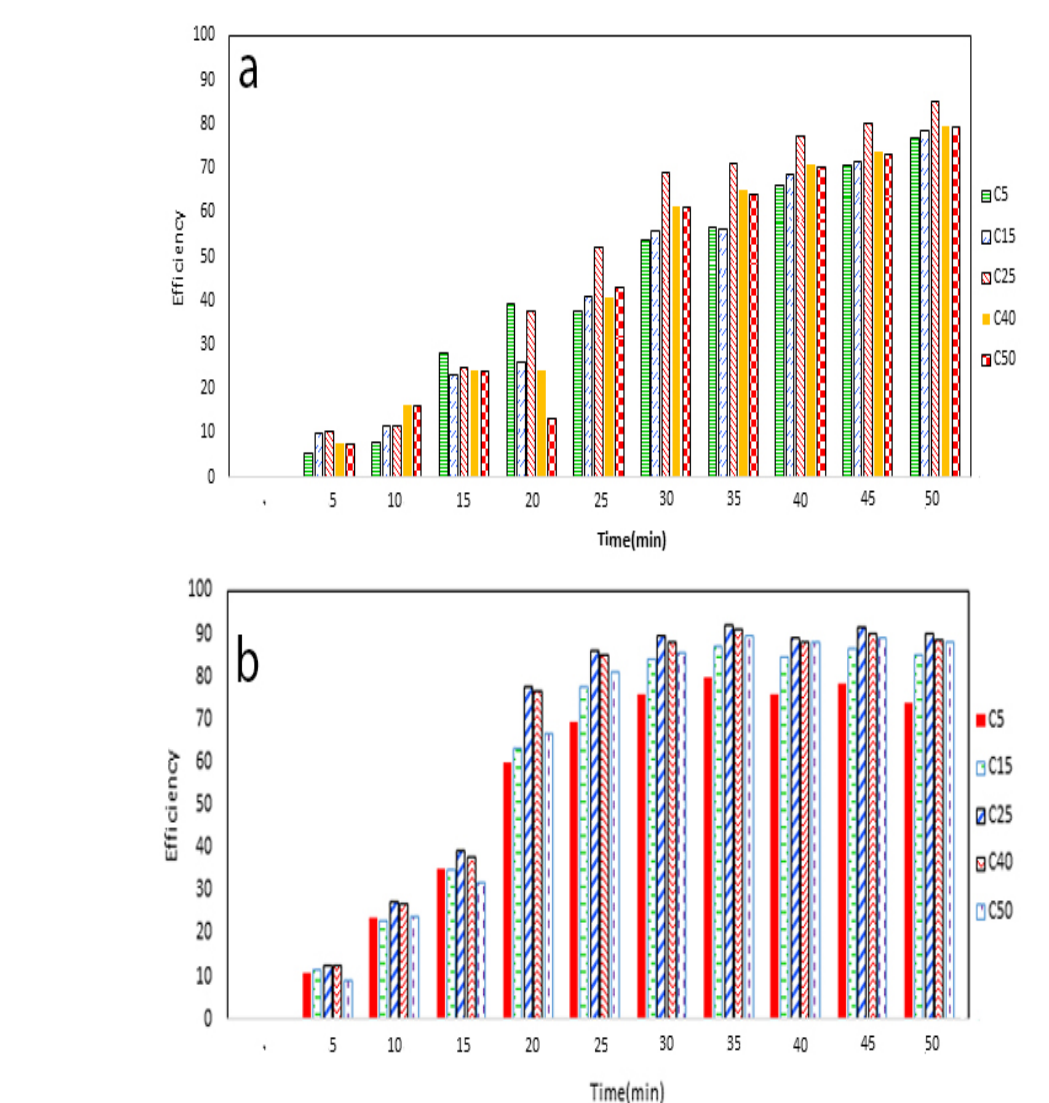
Figure 8. The 1-naphthol degradation efficiency at different Initial concentrations under visible light (5, 15, 25, 40, and 50 mg/L) in the exposure to N,S-TiO coated on glass MS (a) and N,S-TiO /SSA (b) under visible light within 50 minutes 2 2